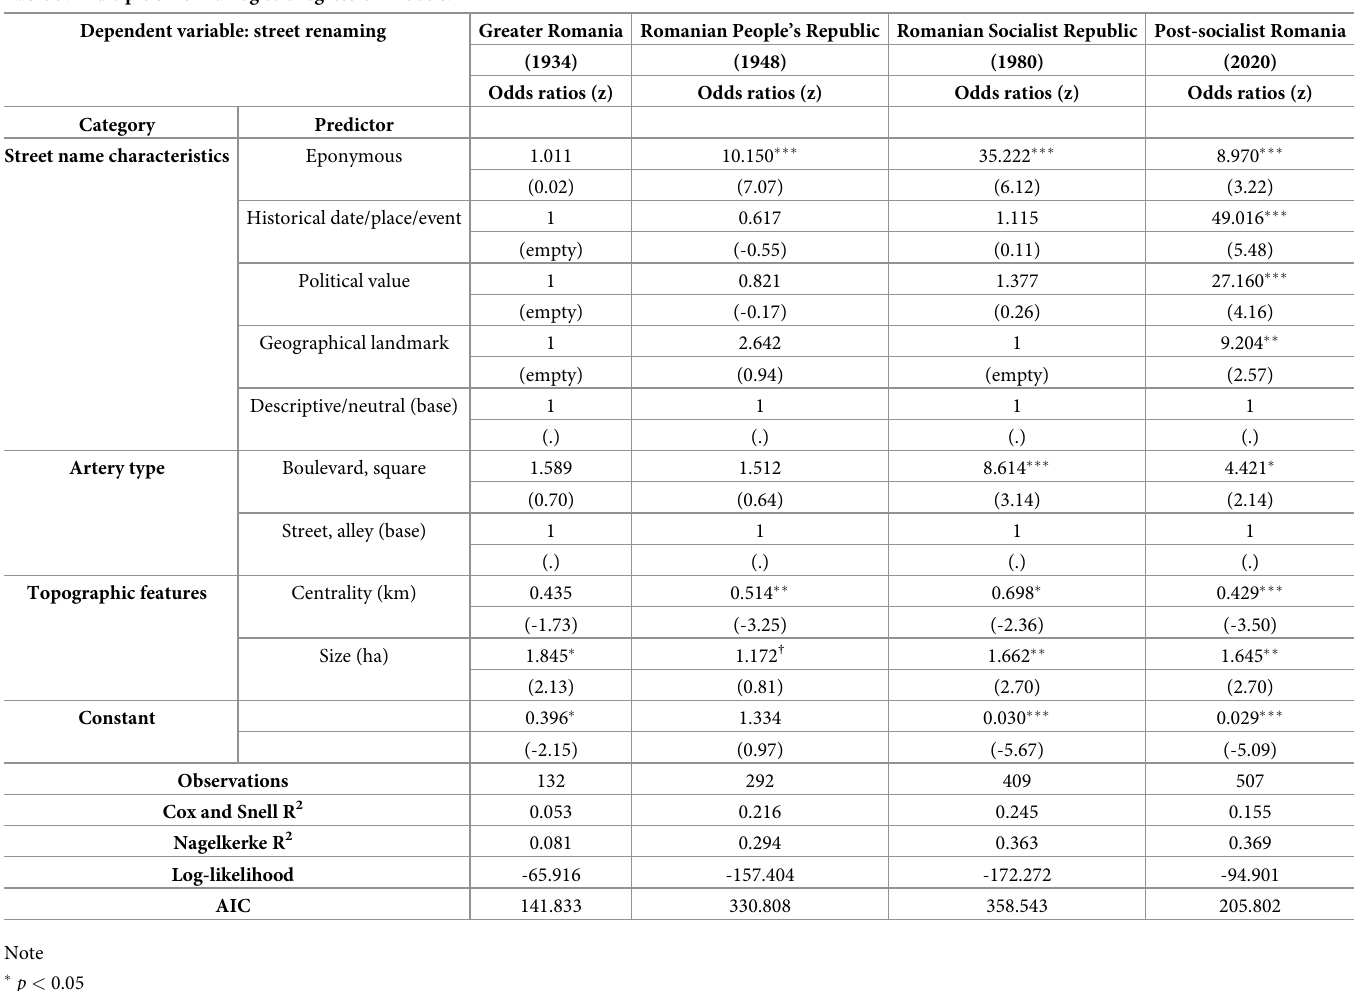
Table 5. Multiple binomial logistic regression